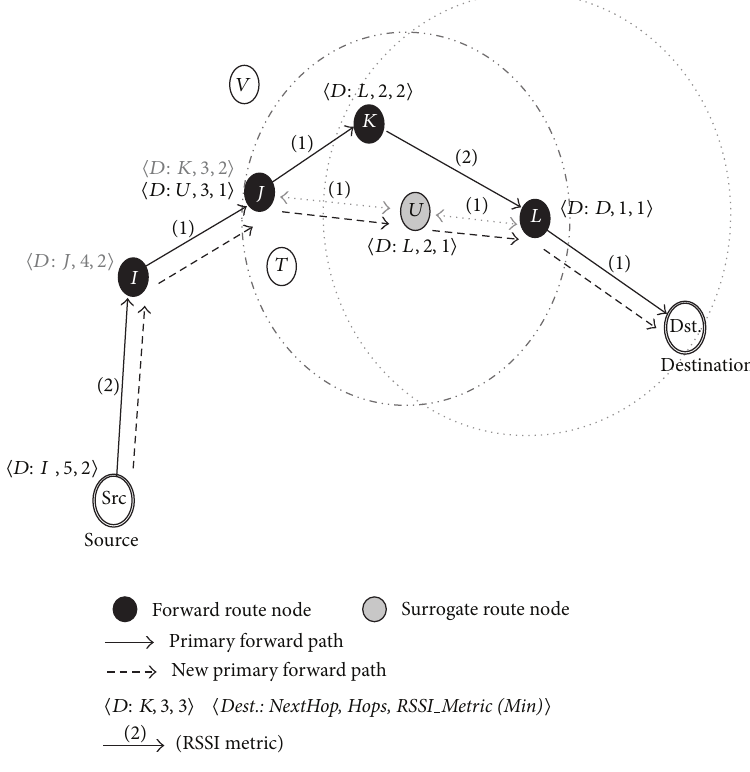
Figure 2: Illustration of the local route update (LPU)